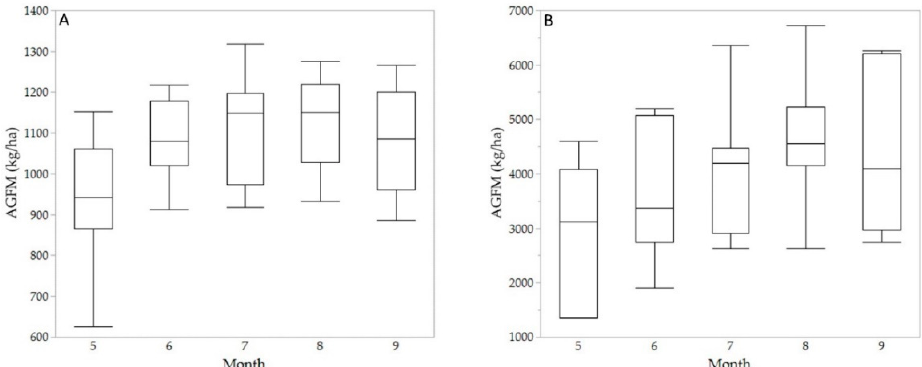
Figure 3. Box plots of AGFM for month of year for KP000a ( A ) and GRL ( B ). The number of years represented in the KP000a and GRL datasets is eight and seven, respectively.